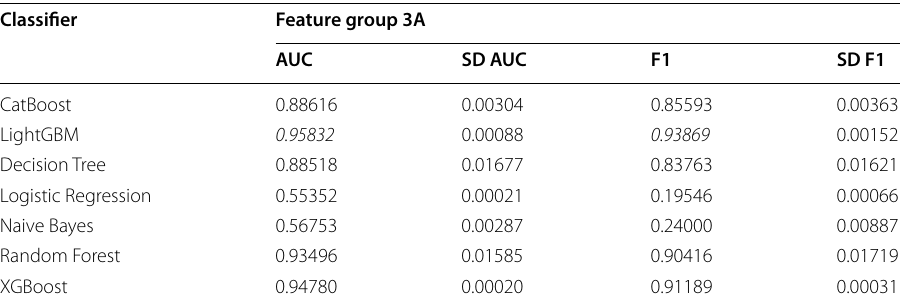
Table 27 Mean performance of 7 classifiers in terms of AUC and F1-score on datasets with features from feature group